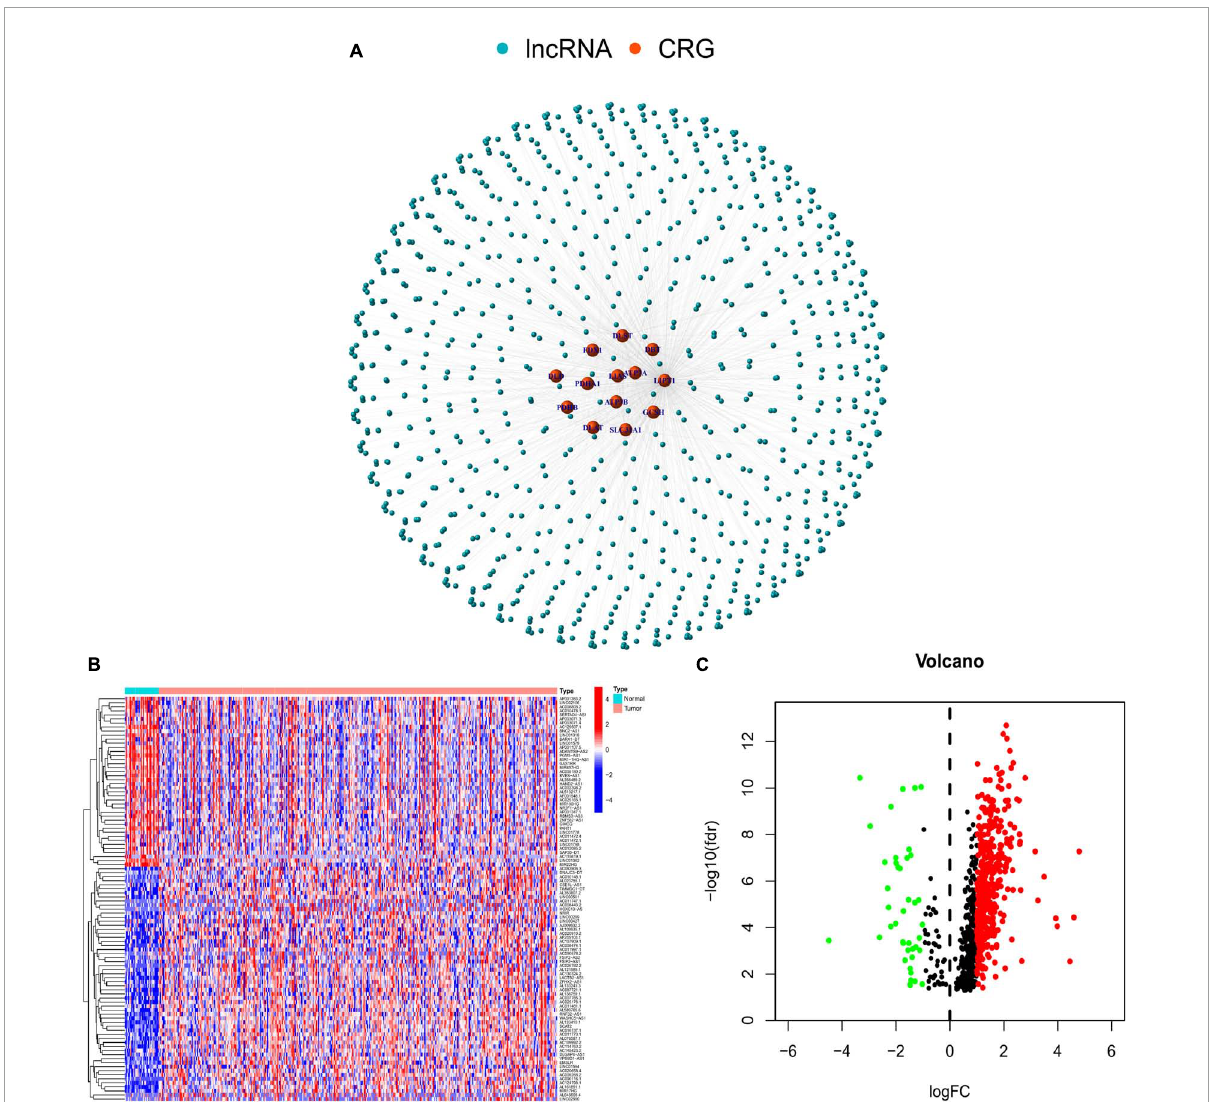
FIGURE1 (A) Network of long noncoding RNAs and cuprotosis-related genes. (B) Differential expression of cuprotosis-related long non-coding RNAs (CRLNCs) between normal and tumor tissues. (C) The volcano plot of CRLNCs. Red represents upregulated CRLNCs; green represents downregulated CRLNCs. CRGs, cuprotosis-related genes; CRLNCs, cuprotosis-related long non-coding RNAs.